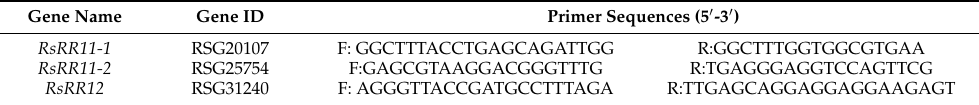
Figure 4. Validation of recommended RGs by normalization of RsRRs expression in the stele. ( A ) Cross-section diagram of the fleshy root in four periods. The area the red arrow points to is the stele; ( B ) relative expression of RsRR11-1, RsRR11-2, RsRR12 derived by normalization of seven commonly used RGs; ( C ) relative expression of RsRR11-1 , RsRR11-2 , RsRR12 derived by normal- ization of nine commonly used RGs ( GAPDH , 18SrRNA , and ACTIN7 added and UBQ11 removed) based on Figure 4B. *, p < 0.05; **, p < 0.01. Table 5. RT-qPCR primer of B-type RsRRs